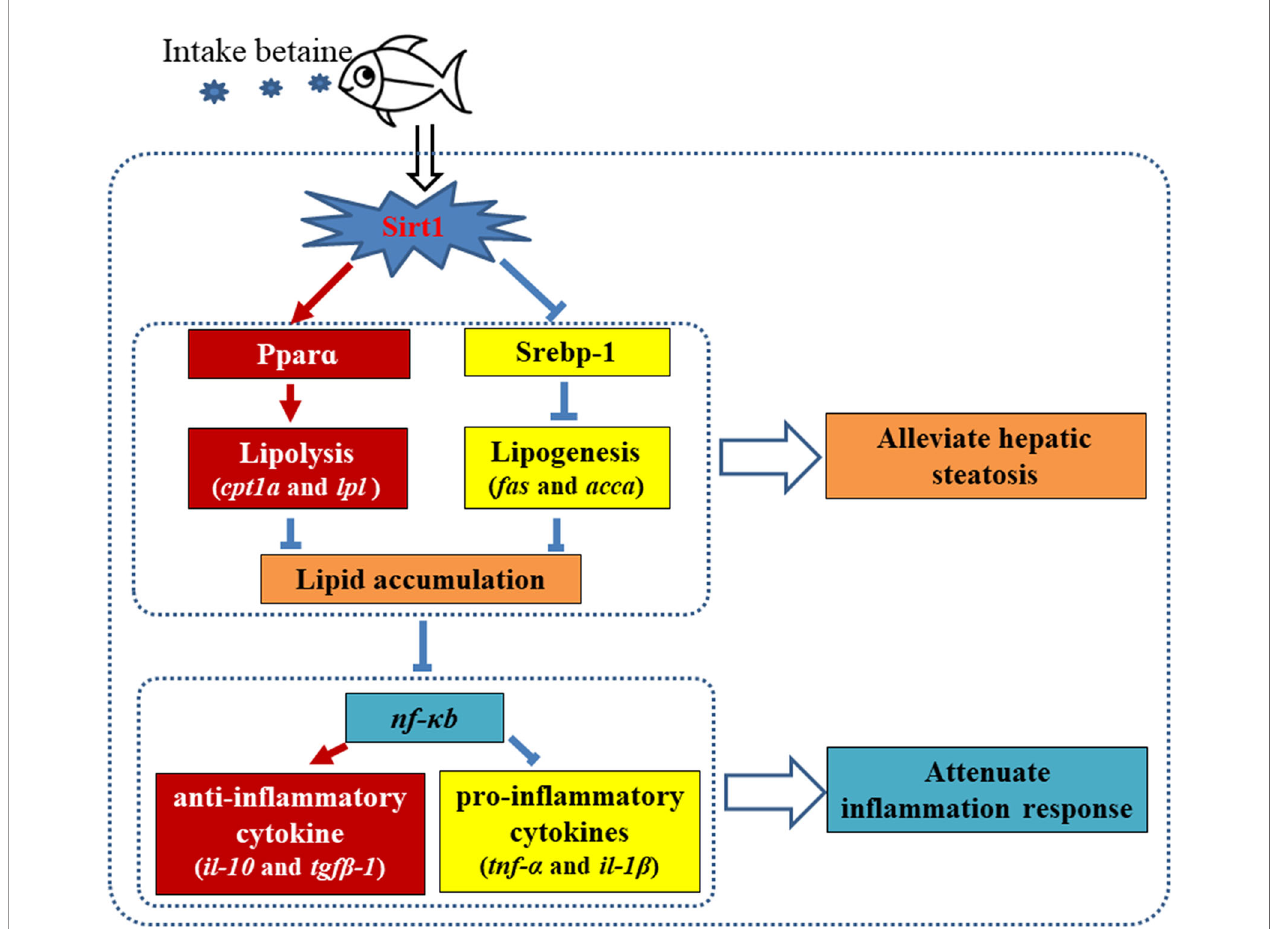
FIGURE 9 | Proposed mechanism of dietary betaine supplementation on alleviating hepatic steatosis and attenuating in fl ammation responses caused by high fat diets in black seabream ( Acanthopagrus schlegelii ). Red arrows represent promotion/up-regulation, blue symbols present